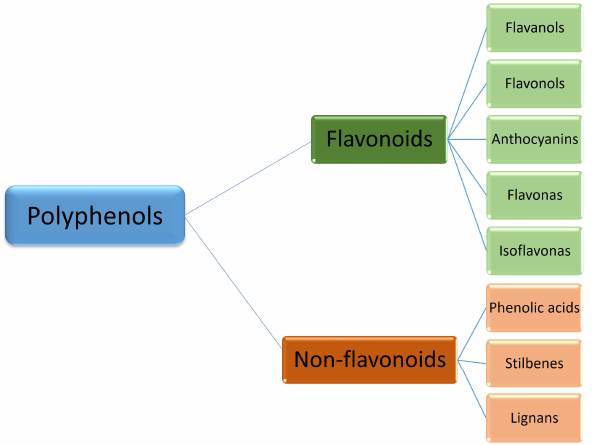
Figure 1. Classification of polyphenols. Adapted from Inchingolo et al. [13]; Câmara et al., 2020 [4].